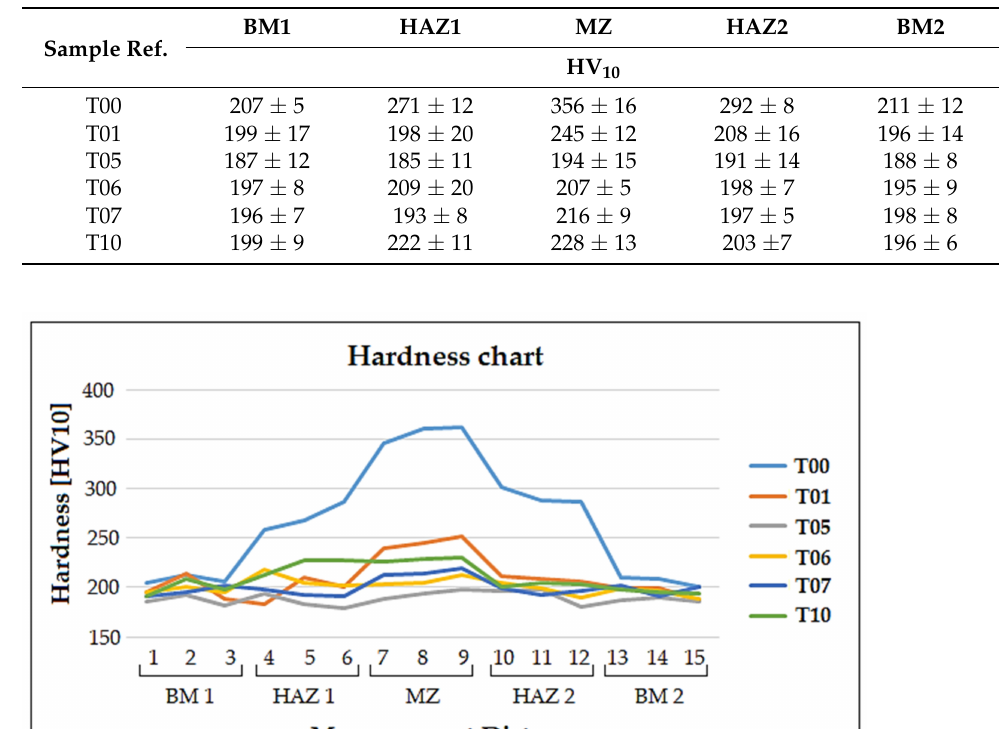
Table 6. Surface hardness of the differently treated welded samples (HV 10 ).